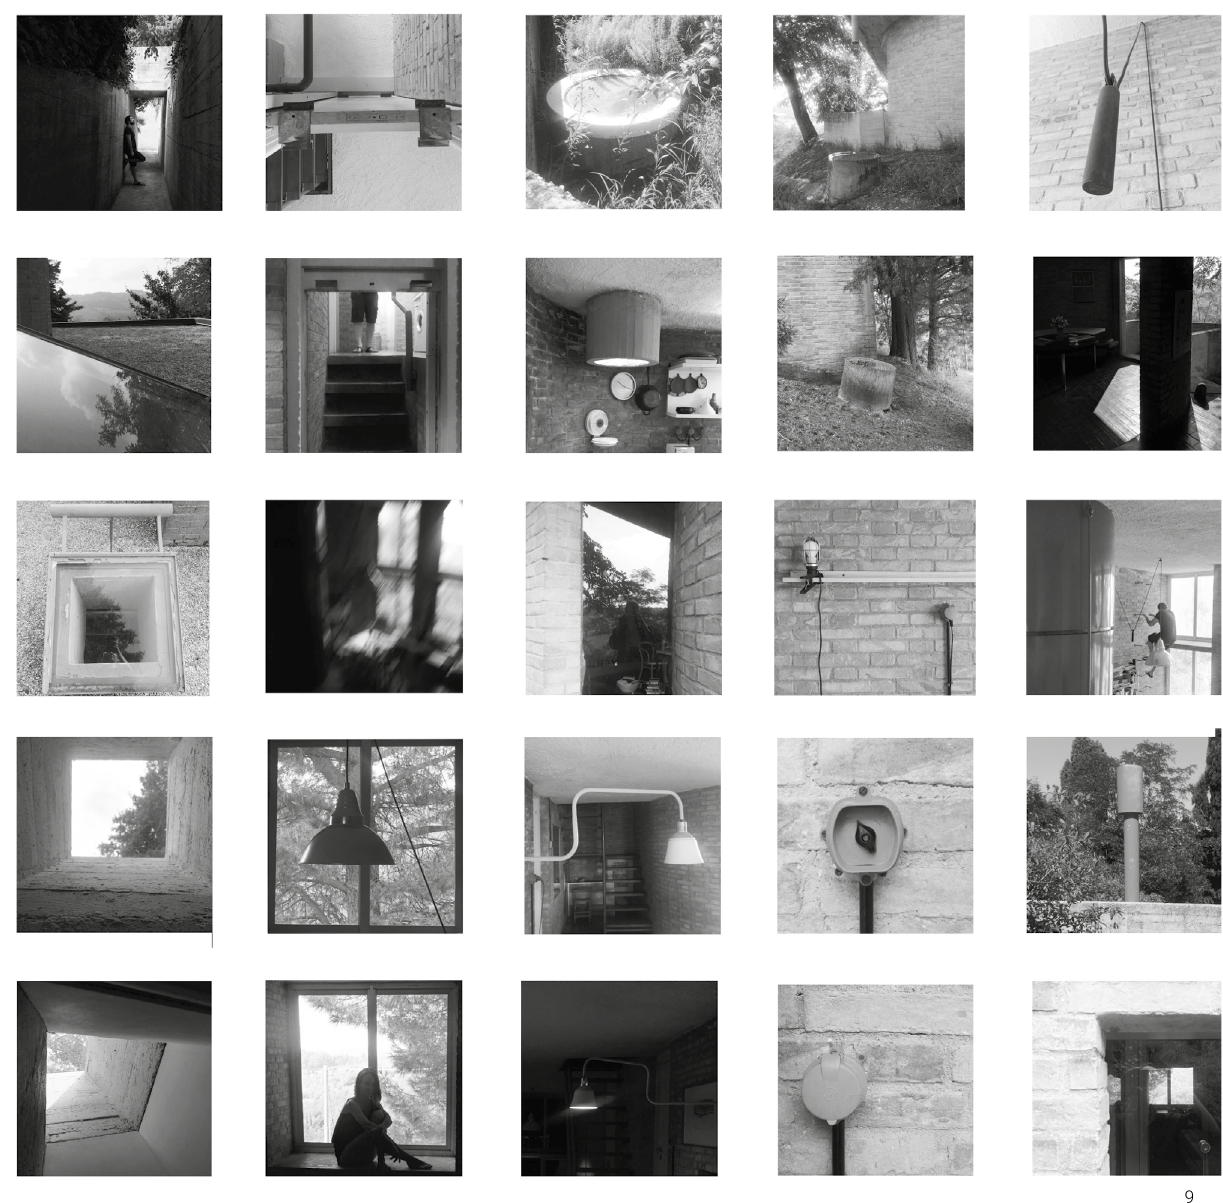
Photographic sequence of scenes and elements of Ca’ Romanino. Source: Photo- graphs by the author, August